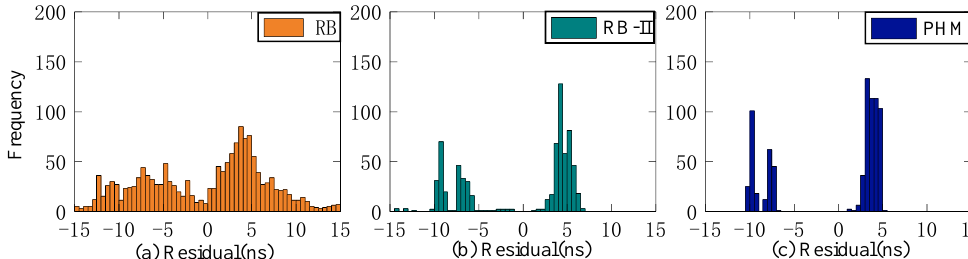
Figure 24. Multiday prediction residual statistics of the QP model. ( a ) The residual distribution of the RB clock. ( b ) The residual distribution of the Rb-II clock. ( c ) The residual distribution of the PHM clock.